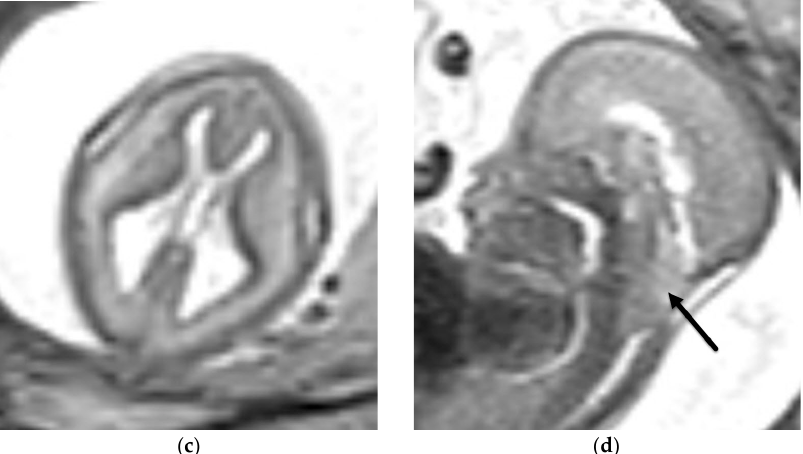
Figure 3. Chiari II malformation. Fetal ultrasound of a 19-week, 6-day GA fetus with myelomeningocele (not imaged) demonstrating the “lemon sign” (( a ), arrows) and the “banana sign” (( b ), arrows). Axial ( c ) and sagittal ( d ) T2-SSFSE images in the same patient show effacement of the extra-axial CSF spaces ( c ) and severe hindbrain herniation (( d ), arrow) consistent with Chiari II malformation.